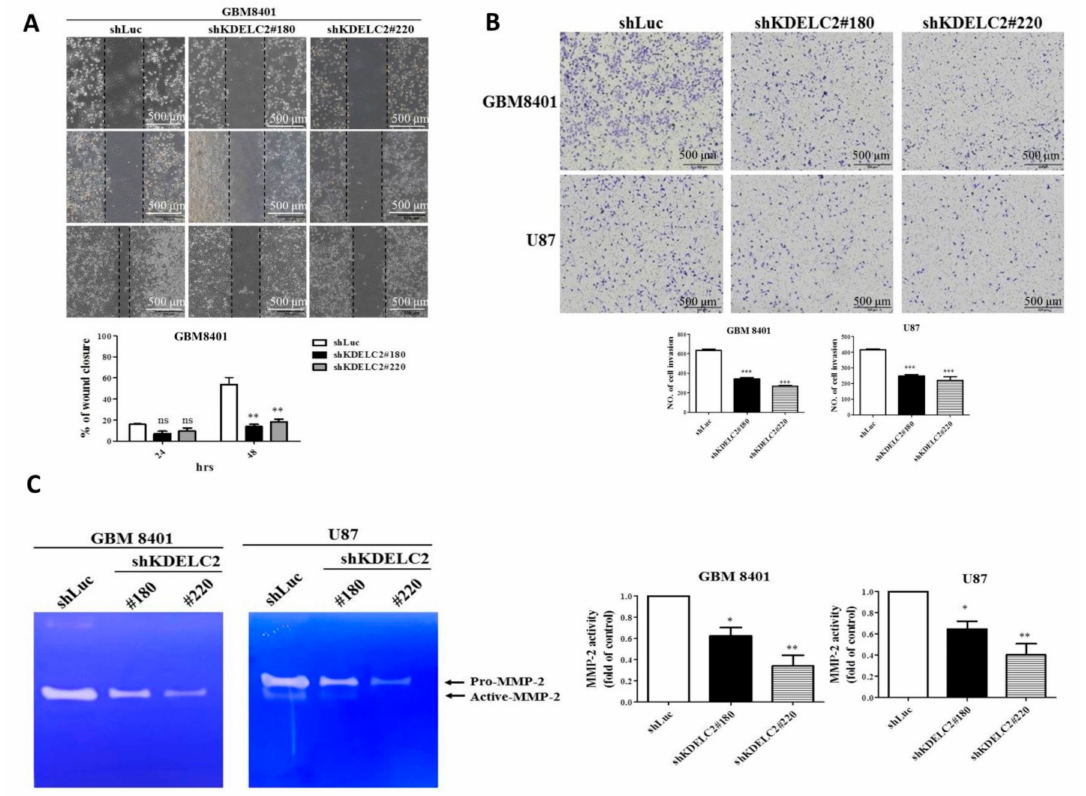
Figure 5. KDELC2 knockdown decreased the tumor-aggressive behavior of glioblastomas (GBMs). ( A ) Knockdown of KDELC2 suppressed GBM migration and ( B ) invasion ability after 48 h of culture. ( C ) Results of gelatin zymography revealed the inhibition of MMP2 after shKDELC2 transfection. Bars, means ± SEM. * p < 0.05; ** p < 0.01; *** p < 0.0001; ns,